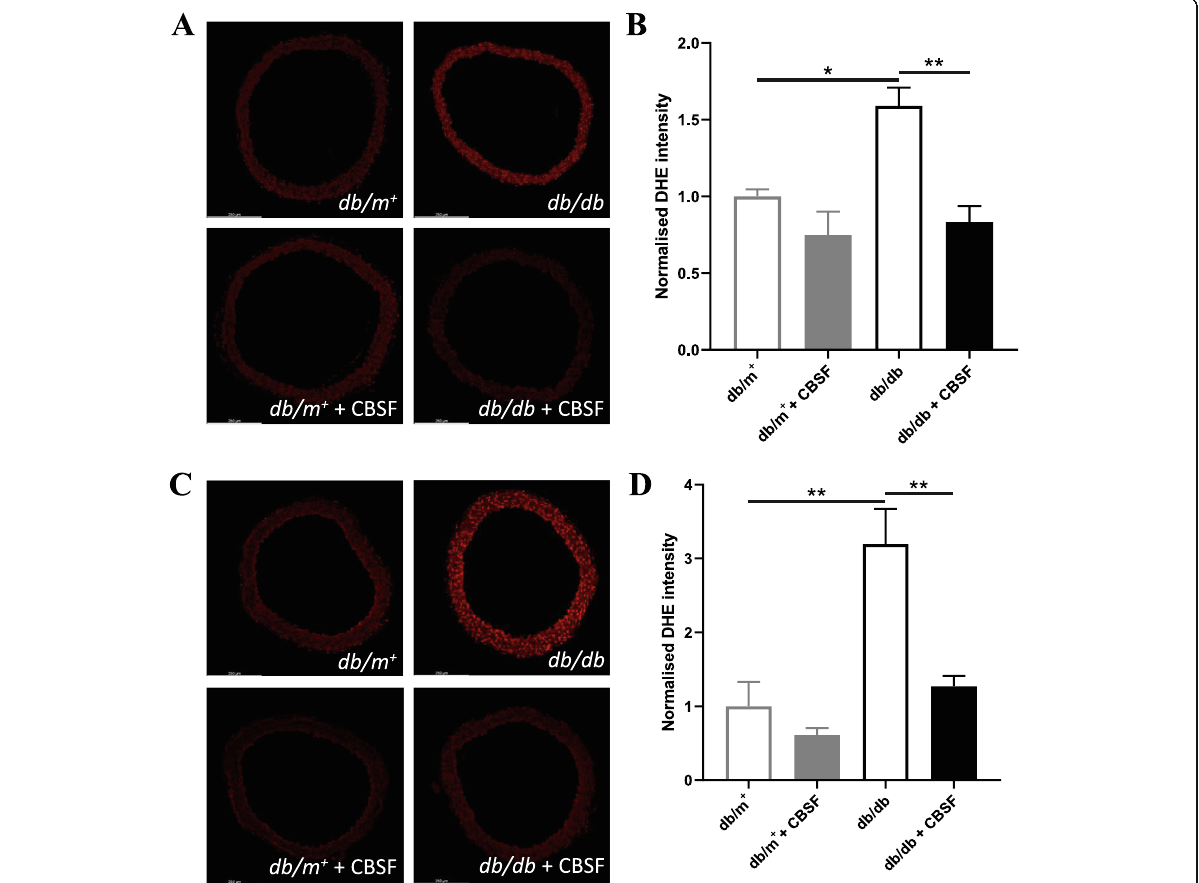
Fig. 4 CBSF suppressed the ROS level in db/db mouse aortae both in vivo and ex vivo. Representative confocal images ( a ) with summarized data ( b ) of DHE stain intensity in isolated aortic rings from db/m + and db/db mice with and without in vivo CBSF treatment (25 mg/kg/day). Representative confocal images ( c ) and summarized data ( d ) of DHE stain intensity in isolated aortic rings from non-treated db/m + and db/db mice with and without ex vivo CBSF incubation (0.4 μ g/mL). Data are presented in means ± SEM; n = 5; * p < 0.05, ** p < 0.01. CBSF, crocodile blood soluble fraction; ROS, reactive oxygen species; DHE,